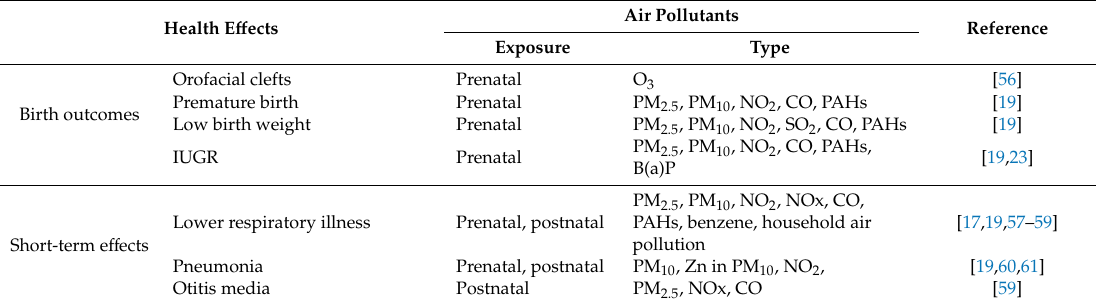
Table 1. Health e ff ects of air pollution exposure in the first 1000 days of